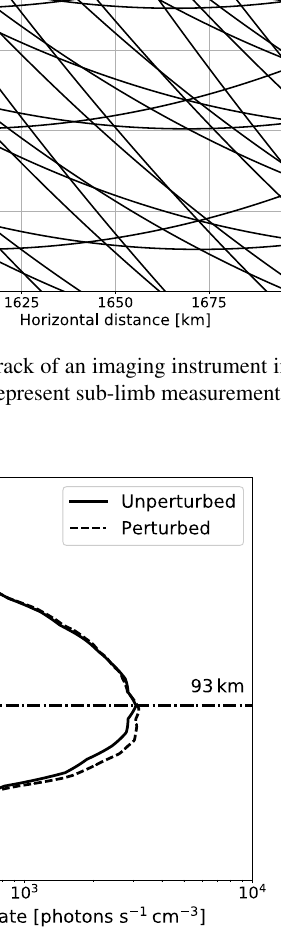
Figure 3. Modelled O 2 A-band nightglow emission profile at 30 ◦ N and 88 ◦ E for 22:00 local solar time as simulated by the HAMMO- NIA model. The solid curve represents an O 2 A-band profile for unperturbed conditions, and the dashed curve represents a profile perturbed by a GW with 15km vertical wavelength and 5K ampli- tude.